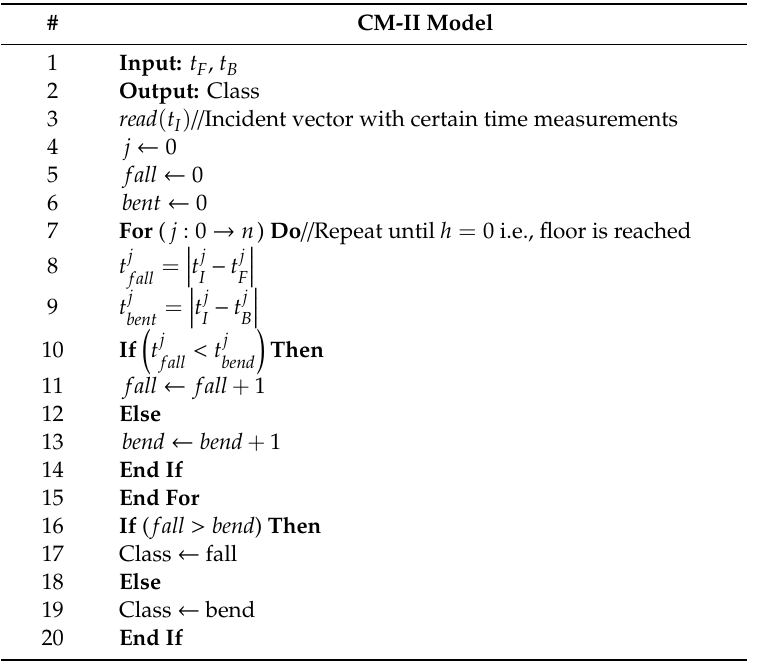
Table 2. Classification Model